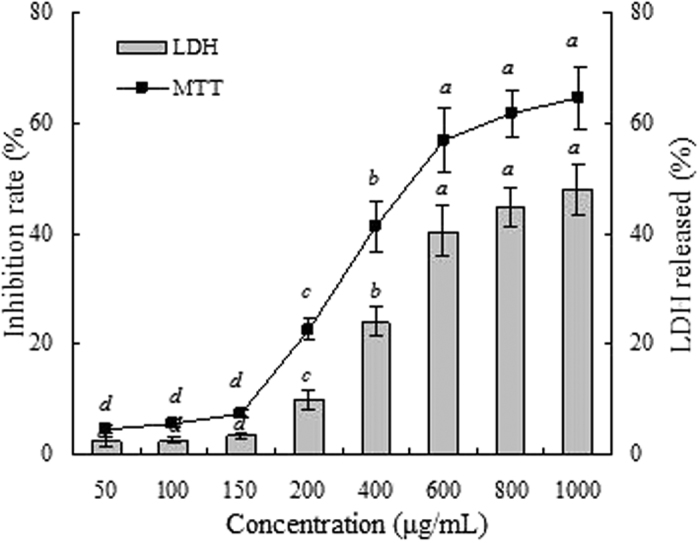
Cytotoxicity of the essential oil by MTT (bar) and LDH (line) assays.